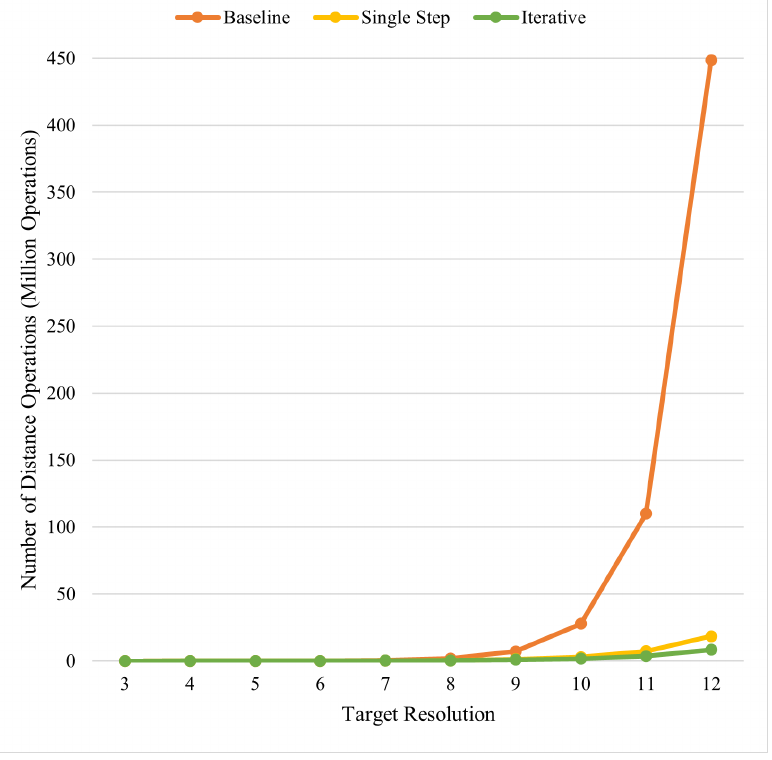
Figure 16. The number of distance operations in different target resolutions for the boundary of